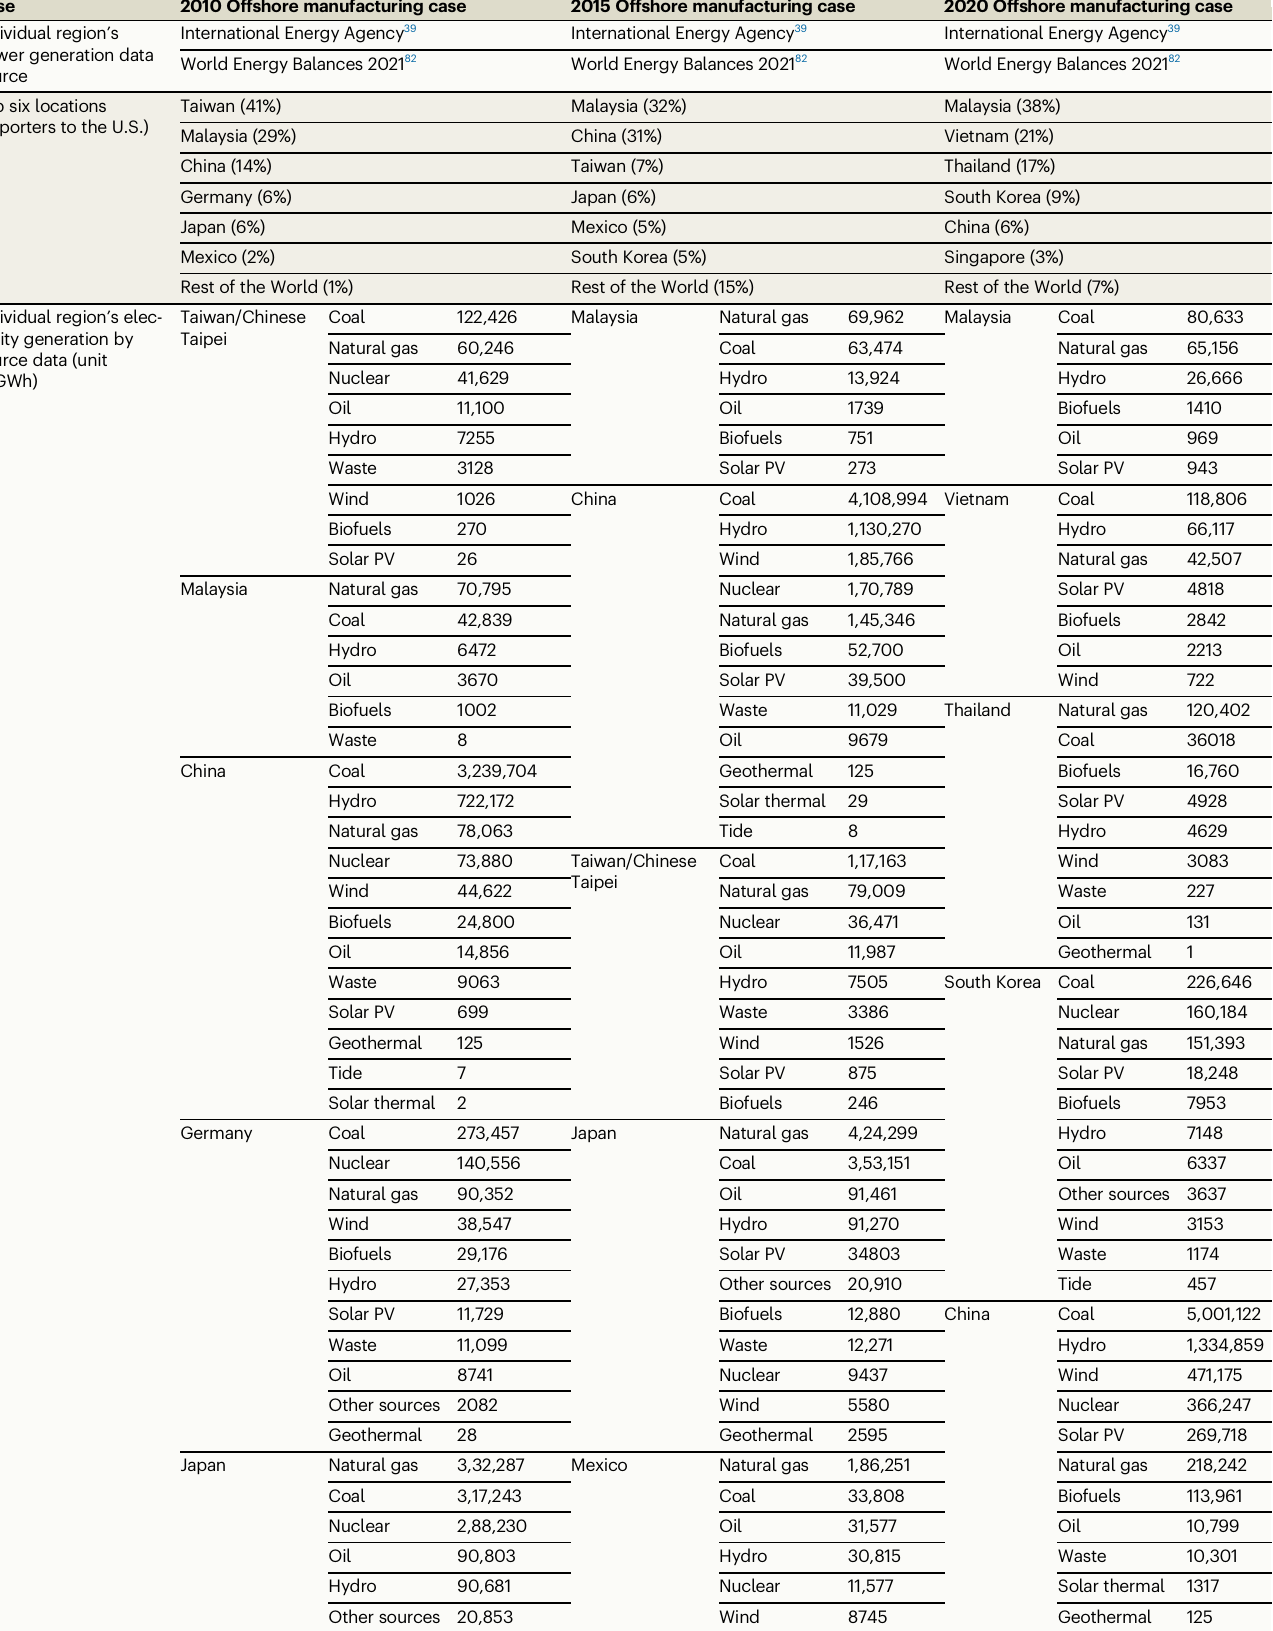
Table 2 | Energy structure of solar PV importers (top six locations), power generation data sources, and emissions generated from each region ’ s unit power usage